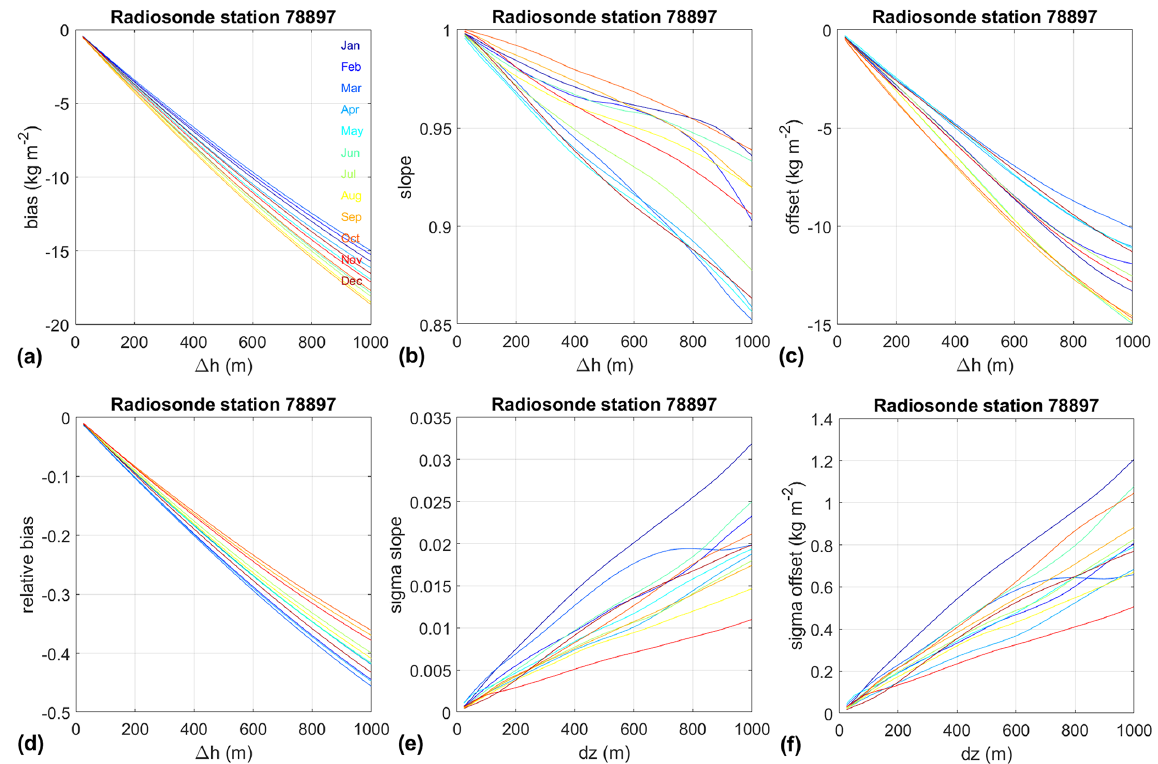
Figure 3. Monthly mean estimates computed from the radiosonde observations shown in Fig. 2c for (cid:49)h = 25 to 1000m in steps of 25m: (a, d) bias, (cid:49) , and relative bias, (cid:49)/µ x ; (b, c) slope and offset parameters fitted from Eq. (B2) by ordinary least squares; (e, f) standard errors of the slope and offset